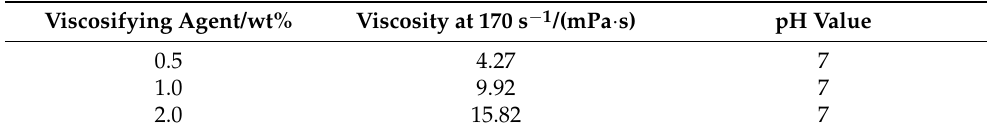
Table 5. Properties of slickwater fracturing